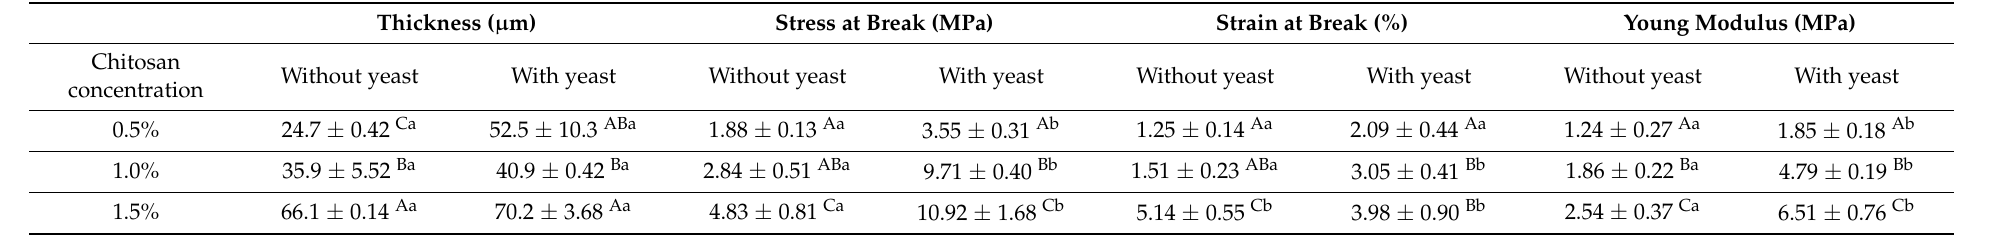
Table 1. Thickness and tensile properties of chitosan films with or without yeasts.